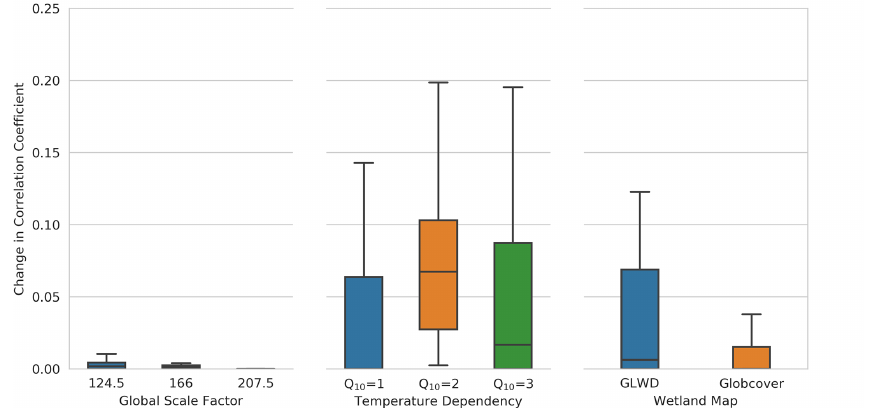
Figure 6. The change in correlation coefficient between the modelled and observed wetland CH 4 seasonal cycle related to each parameter with all other parameters kept constant. The change is calculated as the improvement in correlation coefficient from the lowest value from each set of joined ensemble members. The distribution of this change in correlation coefficient across all regions is illustrated using a box-and-whisker plot with the quartiles indicated by the boxed area and whiskers indicating the remaining data (excluding extreme